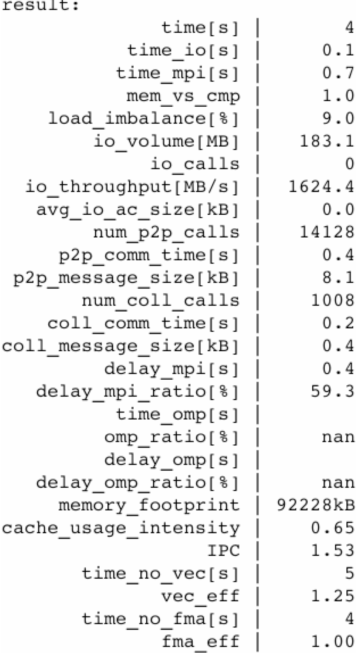
Figure 3. Example output from a performance metric extraction workflow. See Appendix B for a complete explanation of these per- formance metrics and why they might be